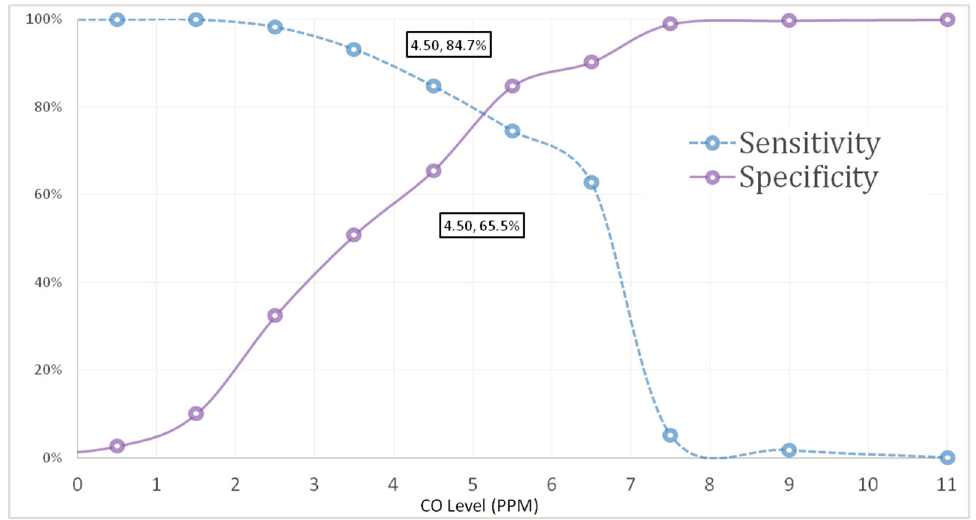
Figure 1. ROC curve for eBCO against self-reported recent cigarette